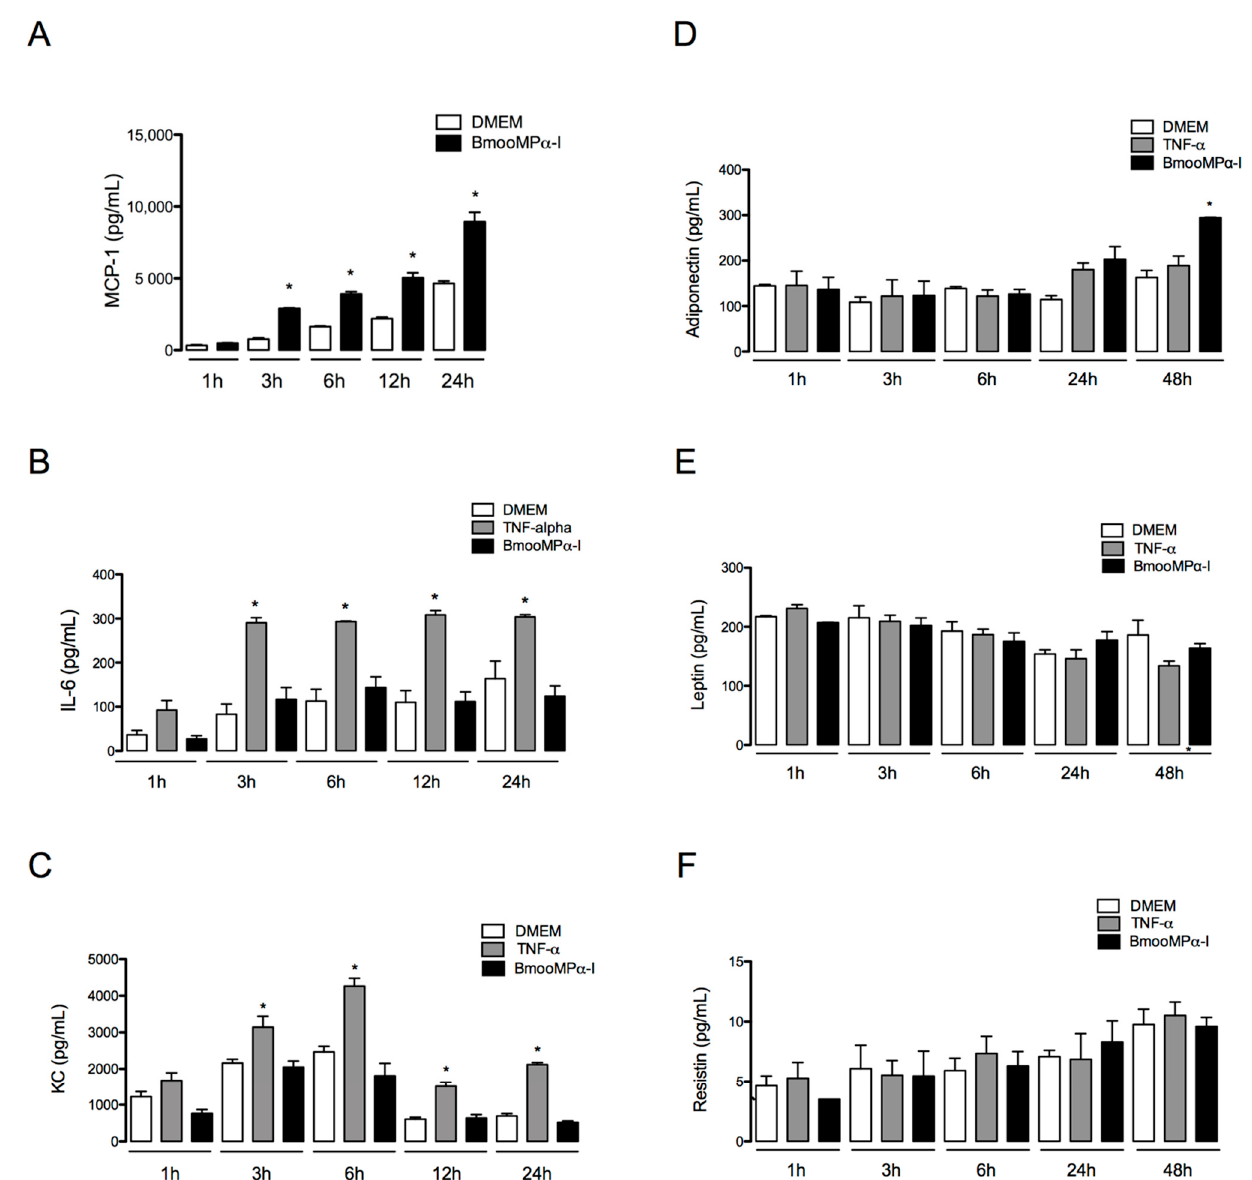
Figure 6. BmooMP α -I induces the release of MCP-1 and adiponectin by preadipocytes. Preadipocytes were incubated with BmooMP α -I (0.24 µ M), TNF-alpha (20 ng/mL—positive control), or DMEM (control) for 1, 3, 6, 12, 24, or 48. Concentrations of cytokines in culture supernatants were determined by CBA and adipokines were quantified by ELISA. Bar graphs show the release of ( A ) MCP-1, ( B ) IL-6, ( C ) KC, ( D ) adiponectin, ( E ) leptin and ( F ) resistin. Each value represents the mean ± SEM of 3 samples. Note: * p < 0.05 vs. control (one-way ANOVA, Bonferroni post-test).